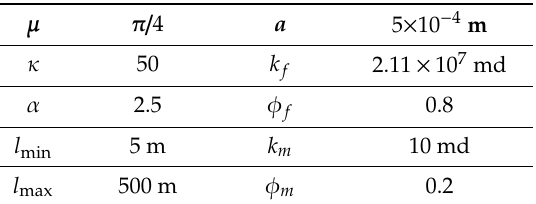
Table 2. Parameters for Case 1.